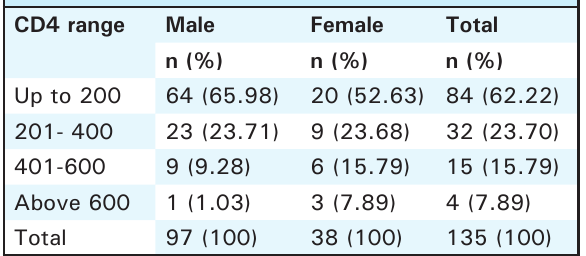
Table 2. Distribution of Subjects by CD4 range and Gender.